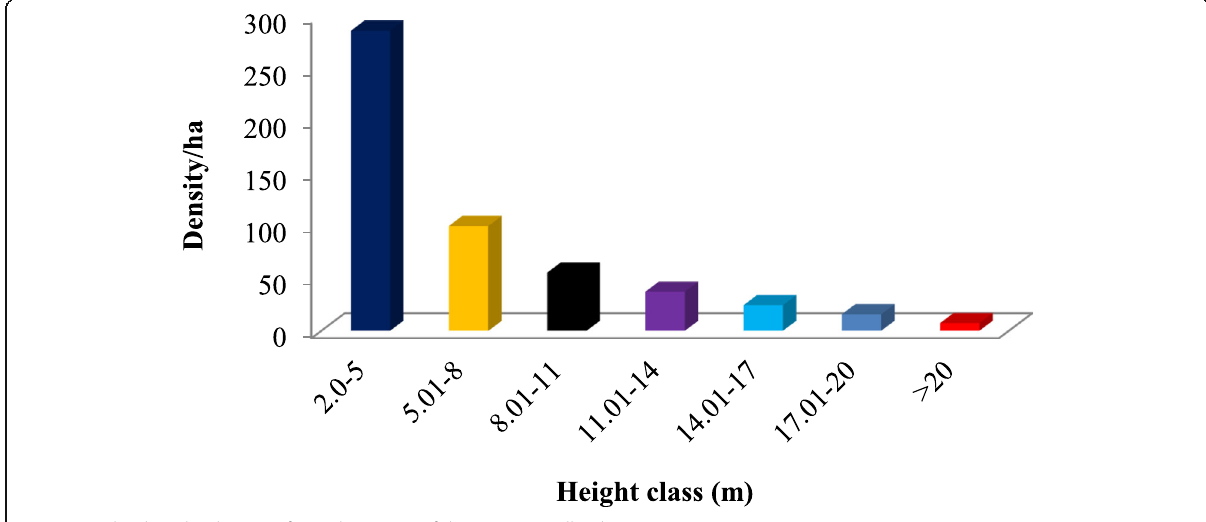
Fig. 6 Height class distribution of woody species of the Hirmi woodland